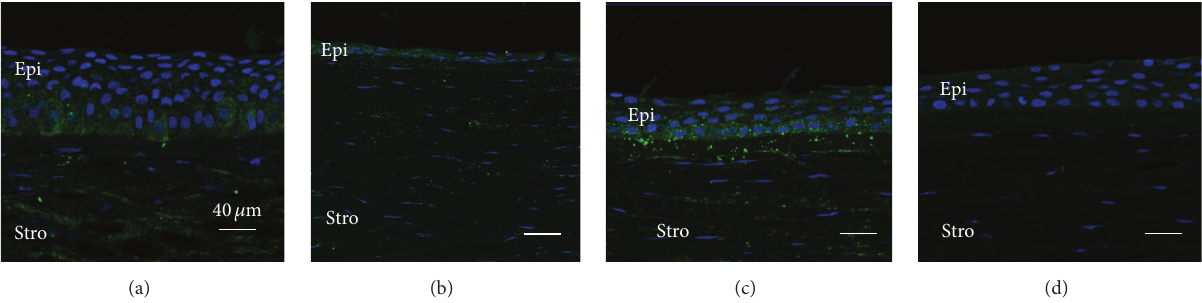
Figure 1: Representative images showing increased HGF expression in basal epithelial cells adjacent to the cone region in KC (a), compared to the relatively more uniform expression seen in all layers of control cornea epithelium at a similar location (c). Strong HGF stromal staining (keratocyte and extracellular matrix) is also observed in KC and control corneas (a to c). No immunostaining is apparent in the Ig negative control (d). (a) Region adjacent to the cone in KC cornea, (b) cone region in KC cornea, (c) central region of control cornea, and (d) Ig negative